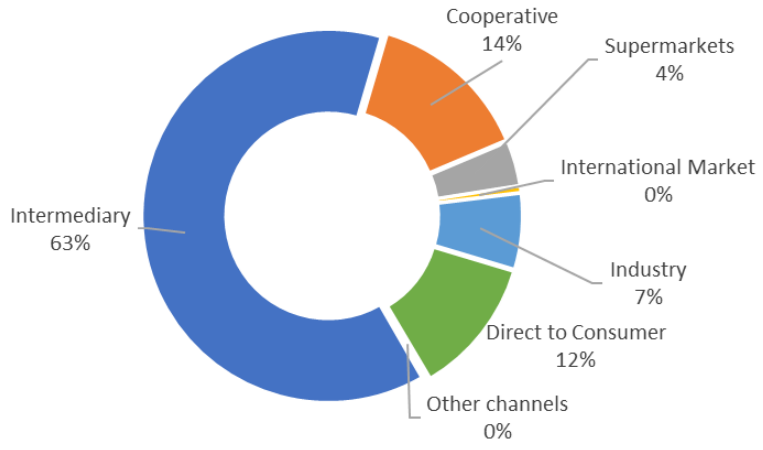
Figure 4. Factors determining the success of productivity based on the census of users of the irrigation districts.